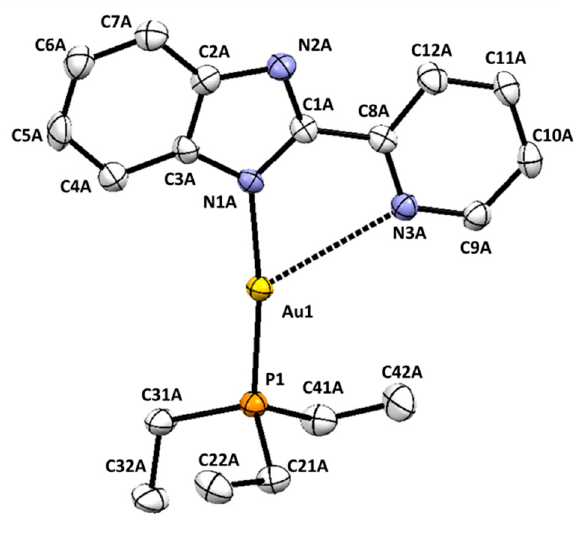
Figure 3. ORTEP representation of one of the molecules presents in the crystal structure of compound 2 (hydrogen atoms have been omitted for clarity). Table 2. Selected bond lengths (Å) and angles ( ° ) for